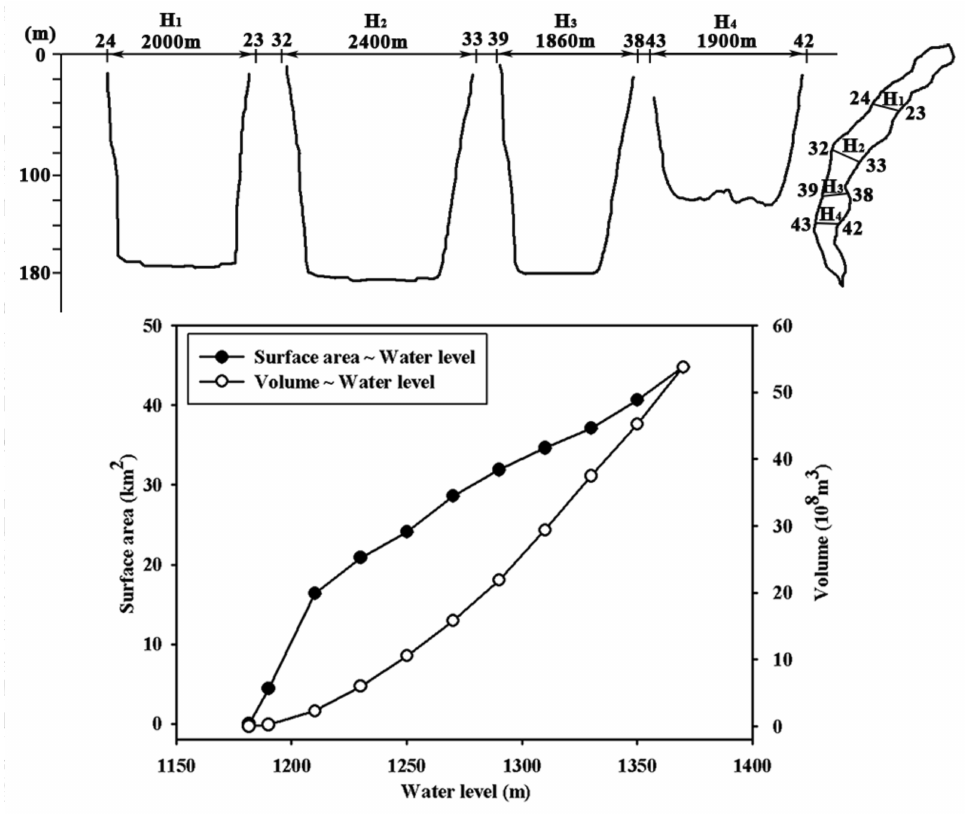
Figure 7. Typical cross section area and relations between water level, surface area, and the volume of Kanas Lake in Region I. (Adapted from Feng et al